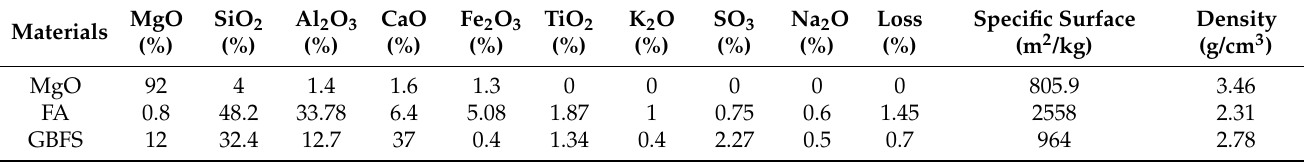
Table 1. Physical and chemical properties of MgO, FA and